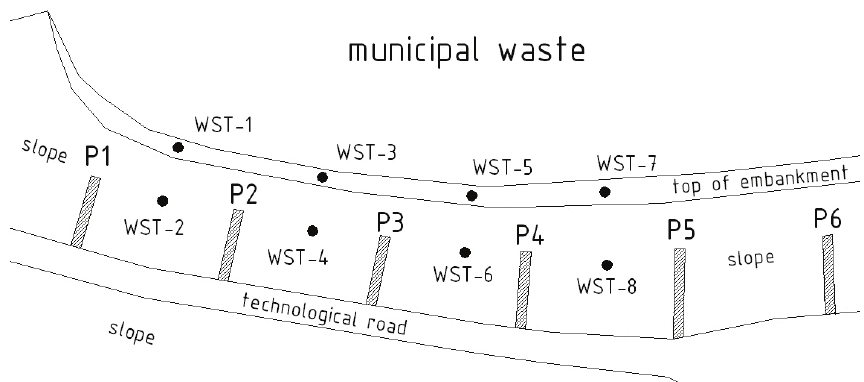
Fig. 3. Location of the WST probing Figure 3 : Location of the WST probing.